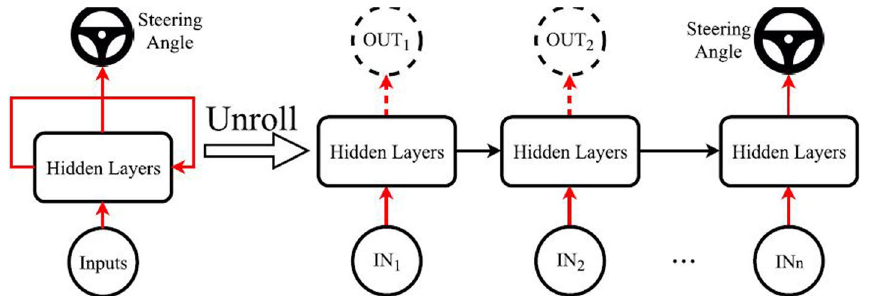
Fig. 4 The basic architecture of RNNs